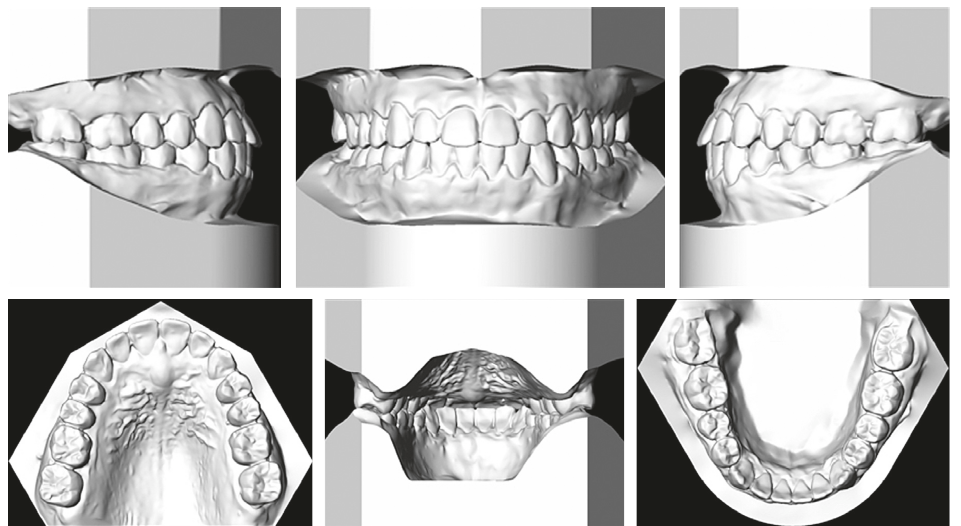
Figure 7: Posttreatment dental